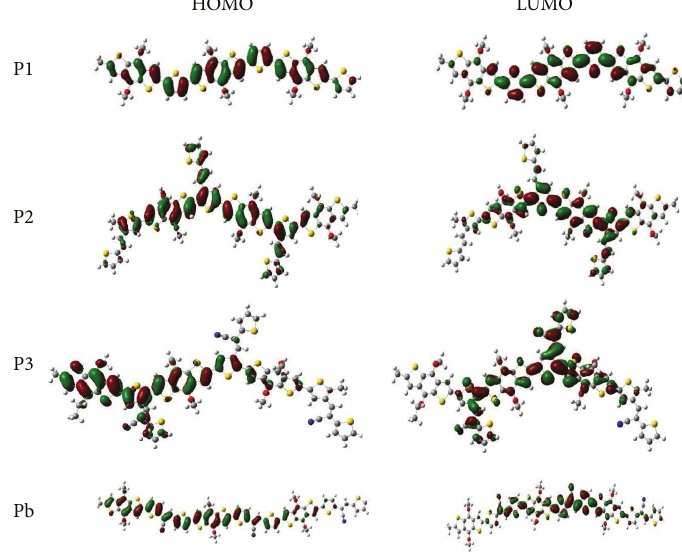
Figure 3: HOMOs and LUMOs surface plots of P1, P2, P3, and PBDT-BTA (Pb) (𝑛 = 3)